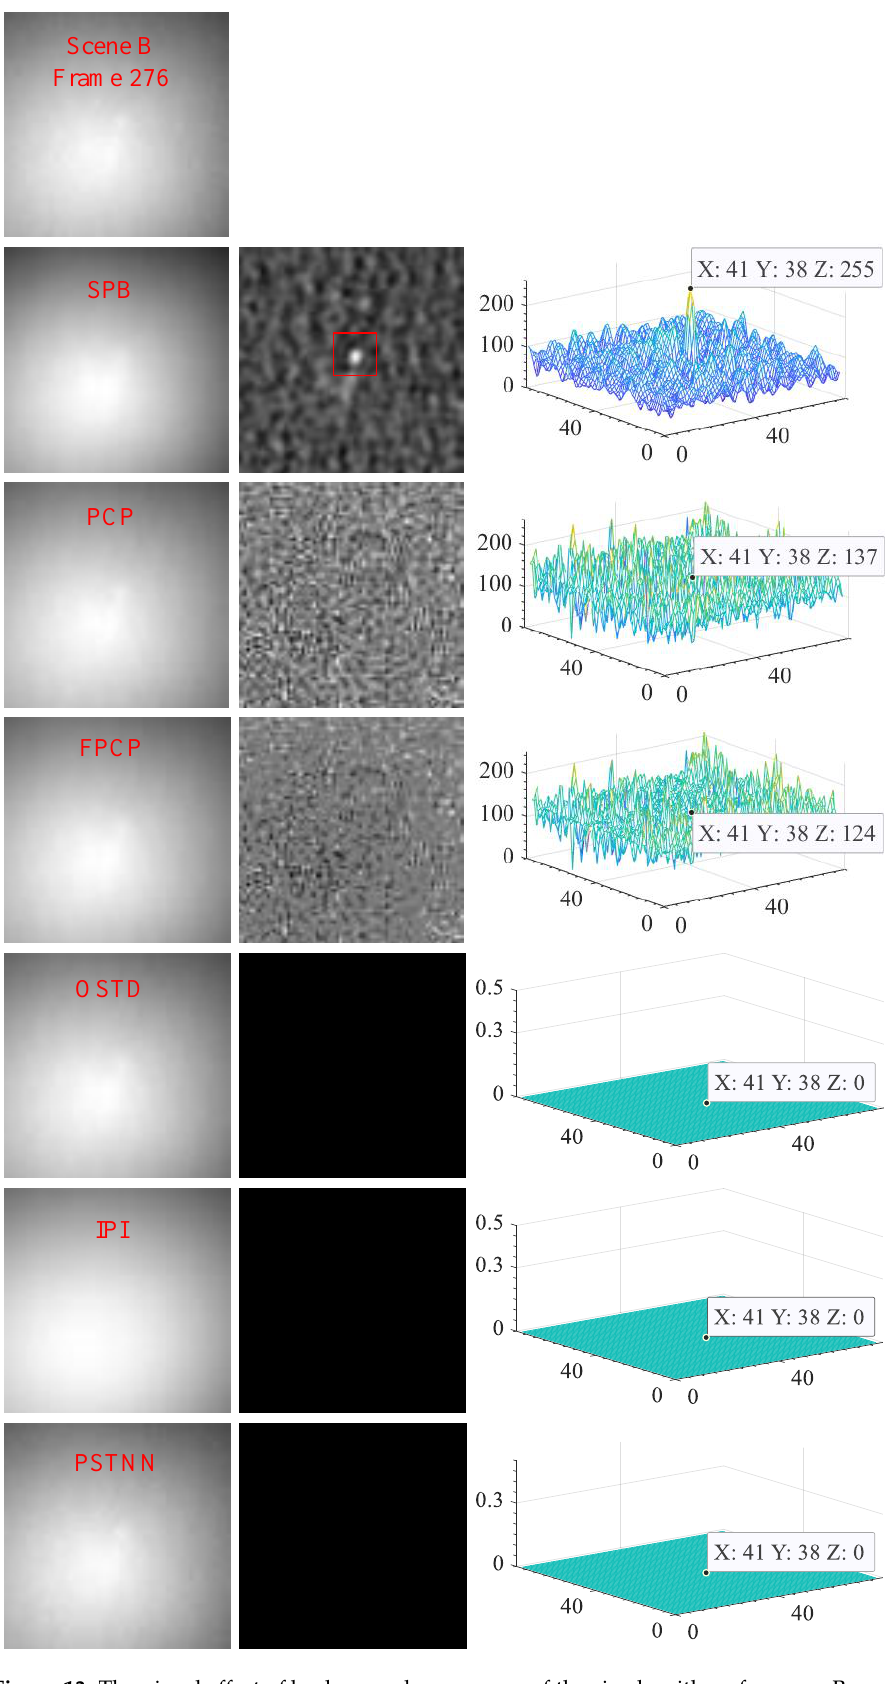
Figure 13. The visual effect of background suppresses of the six algorithms for scene B.